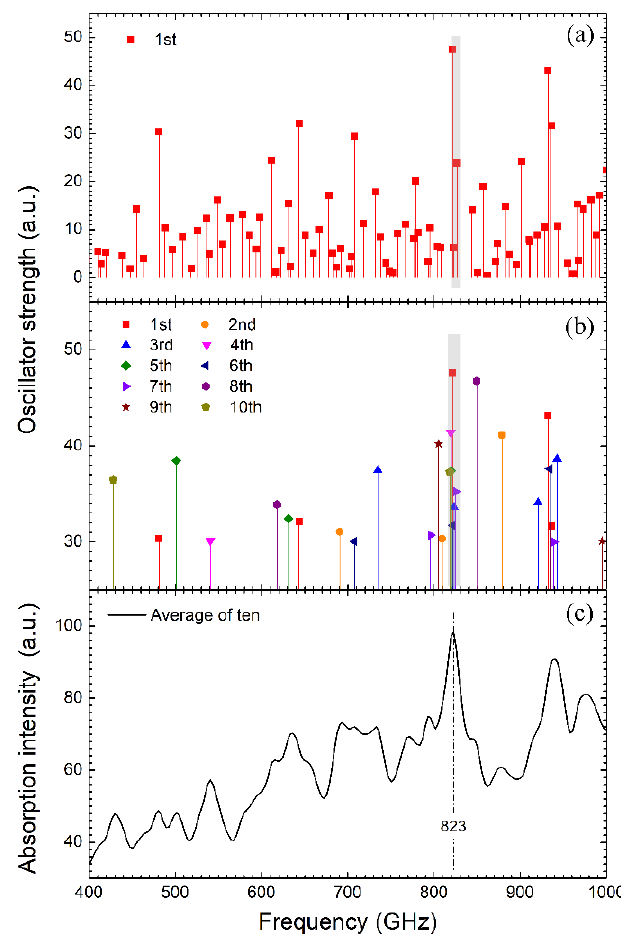
Figure 5. ( a ) Oscillator strengths of the 1st product simulations of the ssDNA in water calculated by the quasi-harmonic approximation; ( b ) Oscillator strengths larger than 30 a.u. in the total ten product simulations; ( c ) Averaged absorption spectrum of the ten product simulations.